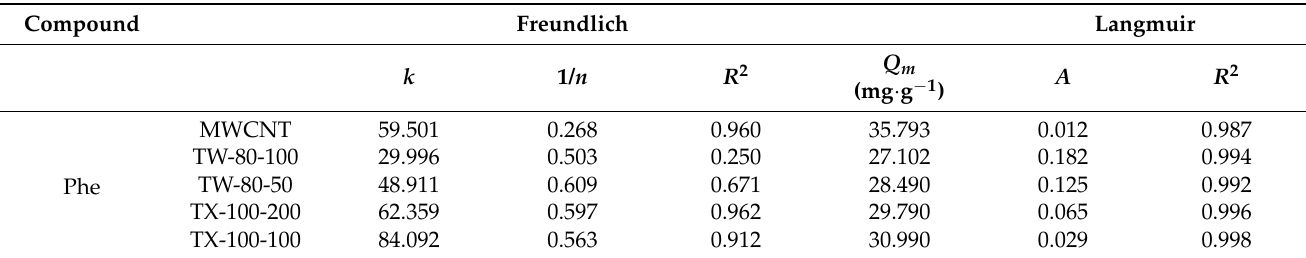
Table 3. Langmuir and Freundlich and dual model parameters for the adsorption of surfactants and Phe onto MWCNTs under TW-80 and TX-100 conditions.